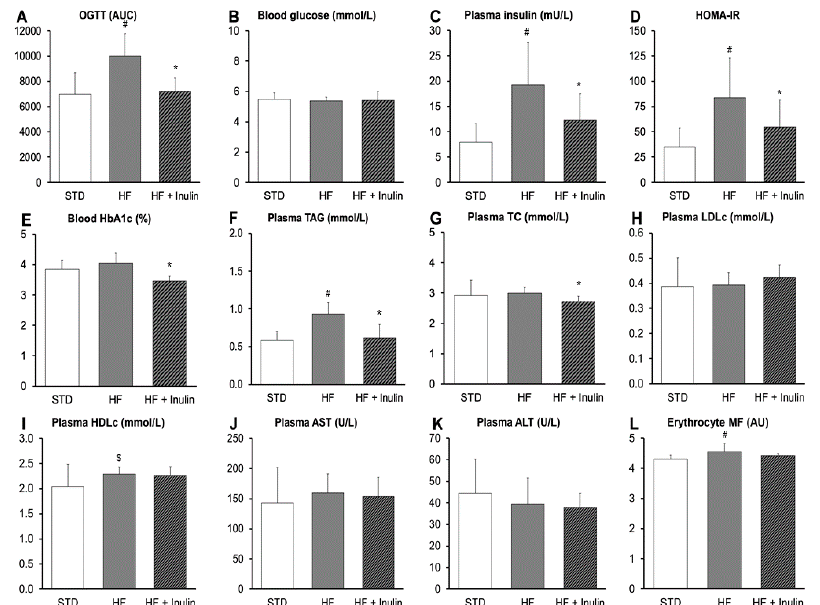
Figure 3. Biochemical parameters of fasting animals. ( A ) Oral glucose tolerance test (OGTT) during week 8. ( B ) Blood glucose. ( C ) Plasma insulin. ( D ) Homeostatic Assessment Model of Insulin Resistance (HOMA-IR, insulin × glucose/22.5). ( E ) Blood glycated hemoglobin (HbA1c). ( F ) Plasma triacylglycerol (TAG). ( G ) Plasma total cholesterol (TC). ( H ) Plasma low-density lipoprotein cholesterol (LDLc). ( I ) Plasma high-density lipoprotein cholesterol (HDLc). ( J ) Plasma aspartate aminotransferase (AST). ( K ) Plasma alanine aminotransferase (ALT). ( L ) Erythrocyte membrane fluidity (MF). Values are expressed as mean with standard deviation. Abbreviations: STD, standard diet; HF, high-fat diet containing 34% sucrose; HF + Inulin, modified HF diet containing 19% sucrose and 15% inulin; AUC, area under the curve (mg glucose/mL blood per 120 min); AU, arbitrary unit. p -Values were calculated using the t -test or the non-parametric Mann–Whitney U test. # p -value < 0.05 vs. STD; $ p -value = 0.075 vs. STD; and * p -value < 0.05 vs. HF.